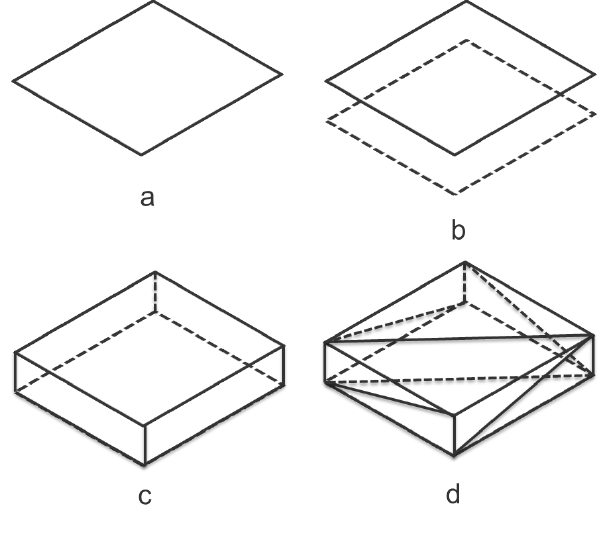
Figure 8: Rectangular cuboid